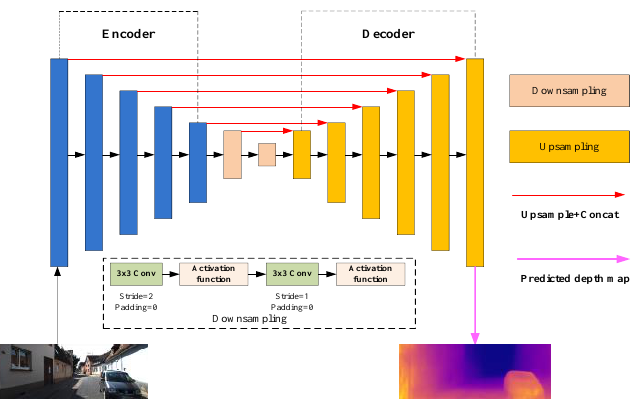
Figure 5. An overview of the proposed depth estimation network.